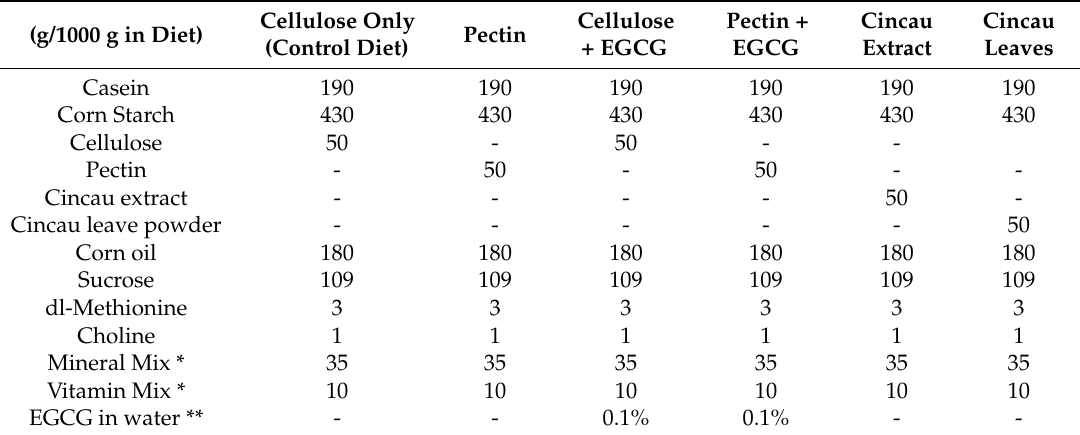
Table 4. Composition of control and experimental